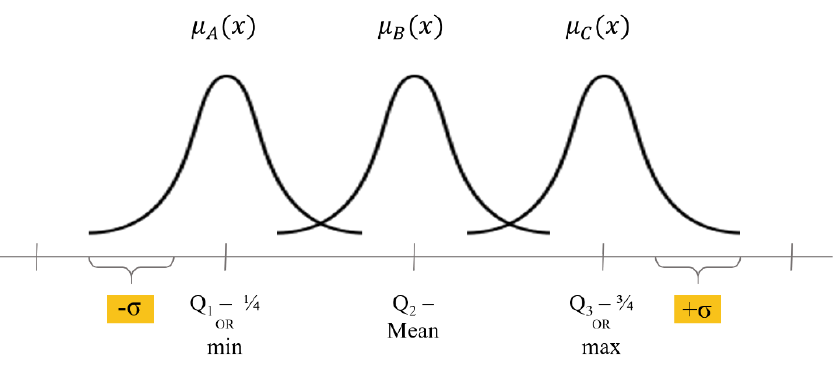
Figure 6. The figure above shows an example of adding and subtracting multiples of the population standard deviation to the minimum and maximum values for the Padding setting. In some cases, the range can be further expanded, such as a factor of 2 or a factor of 3, thereby increasing flexibility and risk.